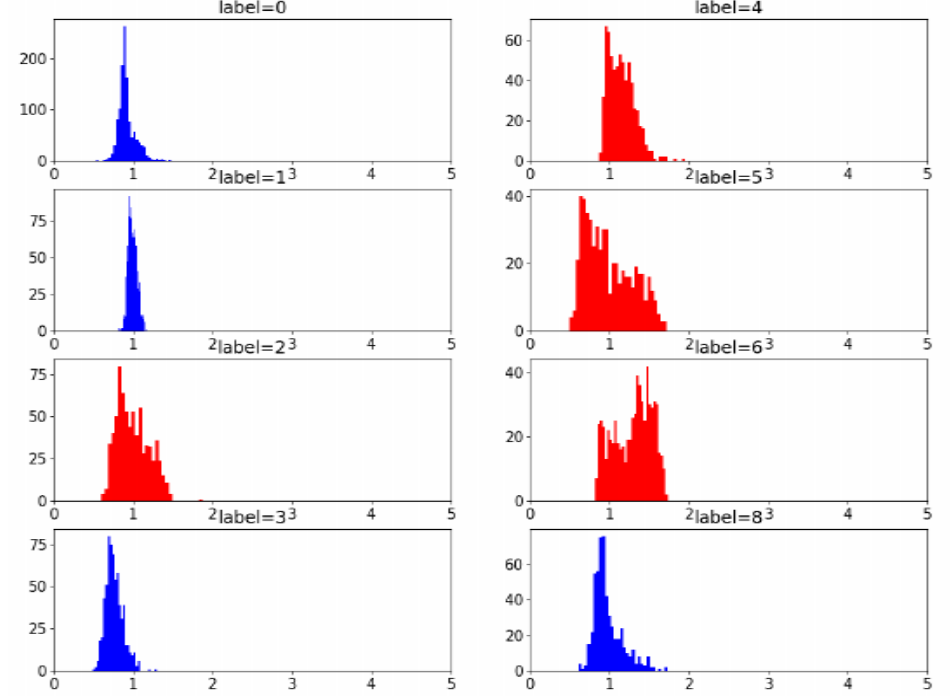
Figure 8. Displacement task: Transfer-relevant (outlier) target instance histograms are depicted in red (blue). The figure is best viewed in